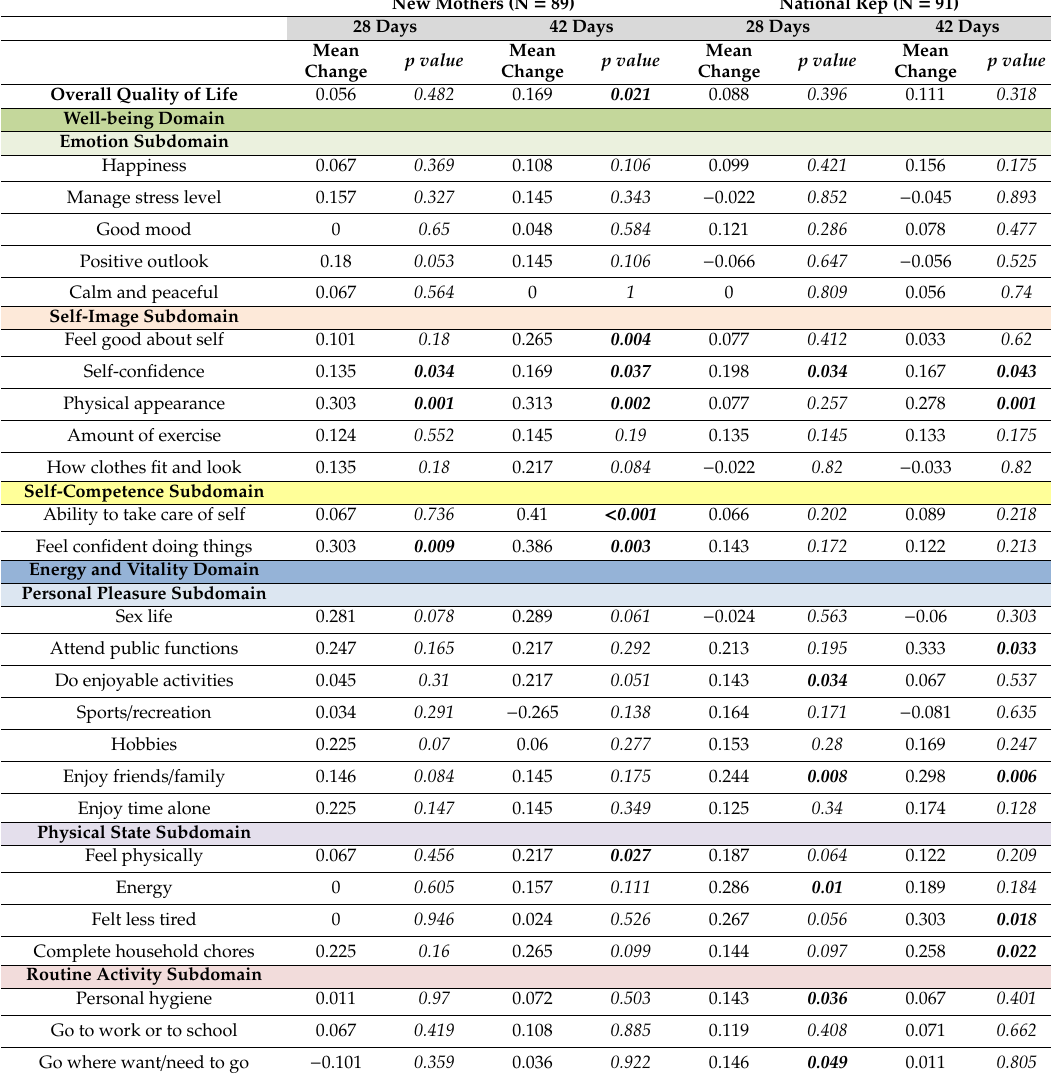
Table 3. Mean change in responses to individual questions in Australia